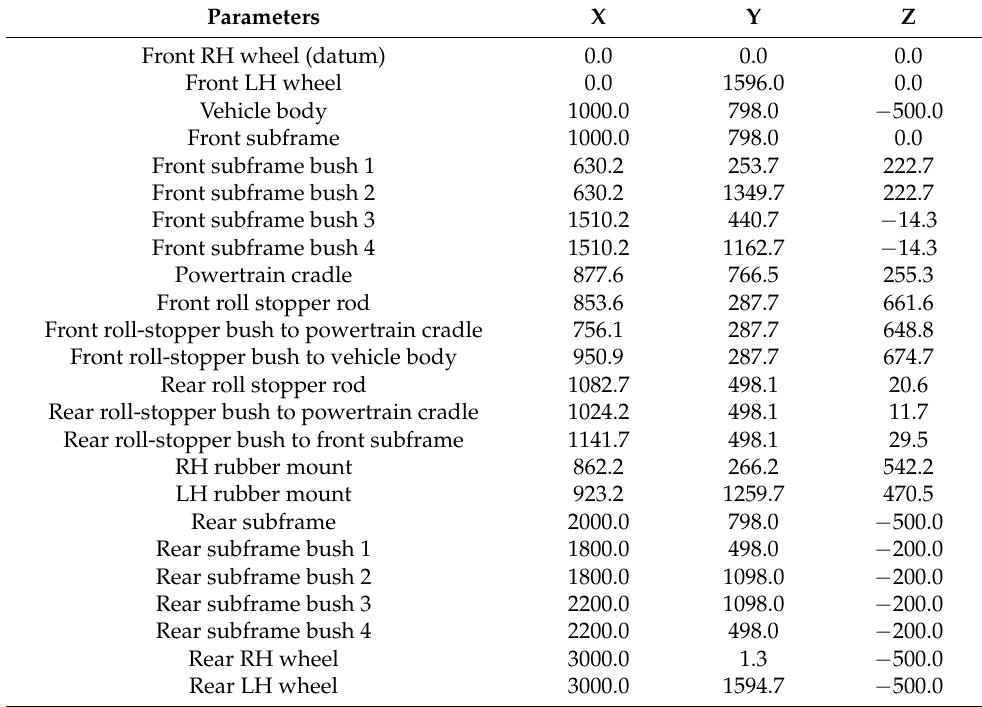
Table A1. Cartesian coordinates of REEV components and compliances in